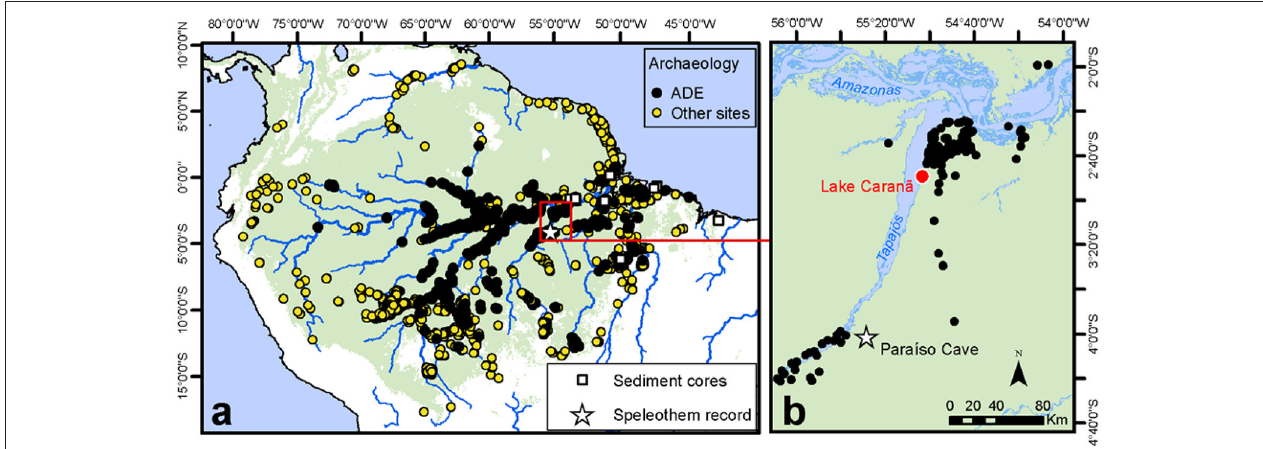
FIGURE 2 | Regional study map. (a) Distribution of ADE and other archeological sites used to calculate the SPD and site frequency values (Maezumi et al., 2018). Red box indicates inset. (b) Study area including LC red dot, star indicate Paraíso speleothem record.